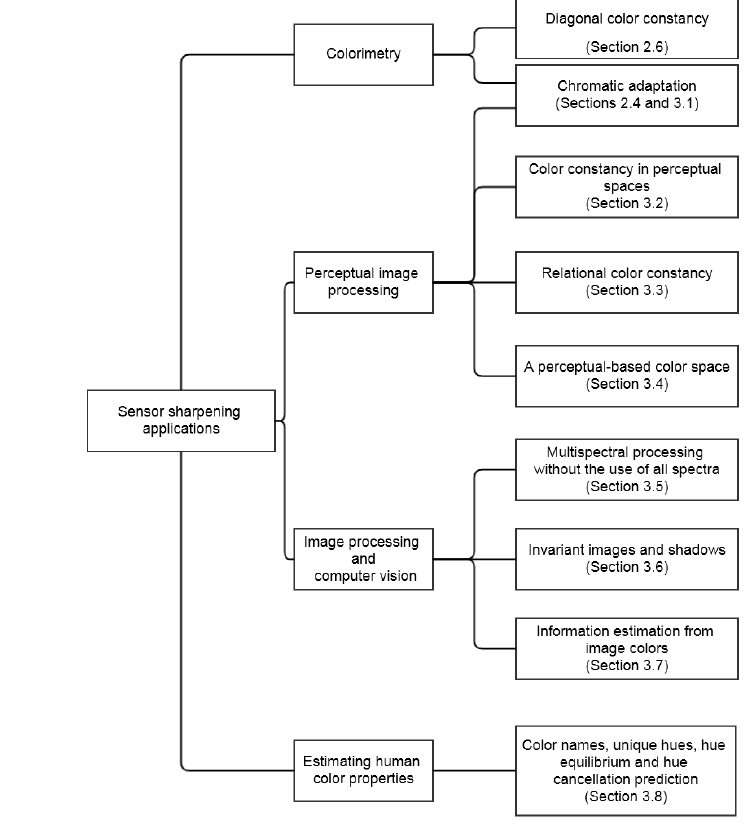
Figure 5. Hierarchy of sensor sharpening applications grouped by research field. Each application is linked to a section in this